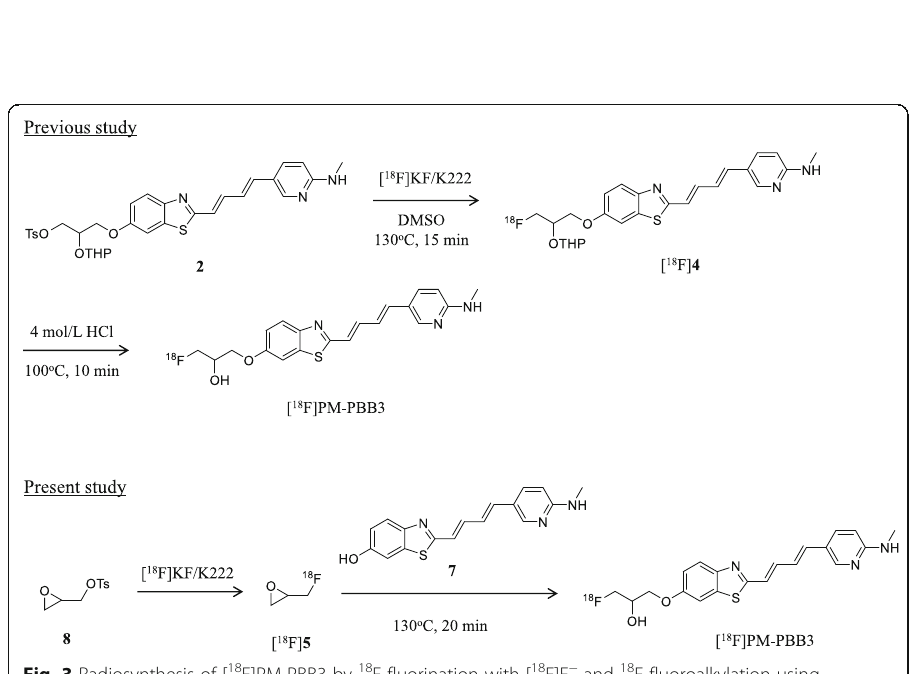
Fig. 3 Radiosynthesis of [ 18 F]PM-PBB3 by 18 F-fluorination with [ 18 F]F − and 18 F-fluoroalkylation using [ 18 F]epifluorohydrin ([ 18 F]5). In this study, after the [ 18 F]F − solution was dried, a solution of 8 (3.5 mg) in o - dichlorobenzene (0.15 mL) was added to the reaction vial containing the dry [ 18 F]F − . The resulting [ 18 F]5 was distilled from the reaction vial and was transferred to another reaction vial containing 7 (1 mg) and 1 mol/L NaOH (3.5 µL) in anhydrous DMF (0.25 mL) maintained at -15 °C. After 2 min of trapping of [ 18 F]5, the reaction mixture was heated at 130 °C for 20 min to obtain [ 18